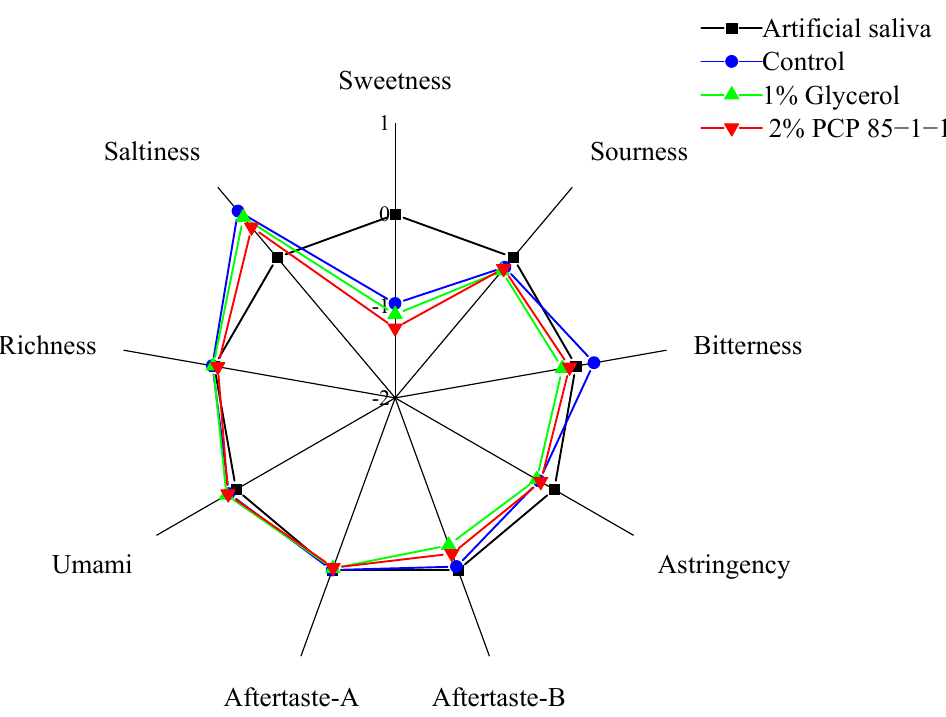
Figure 6. Radar chart of electronic tongue data for the taste of tobacco shreds with